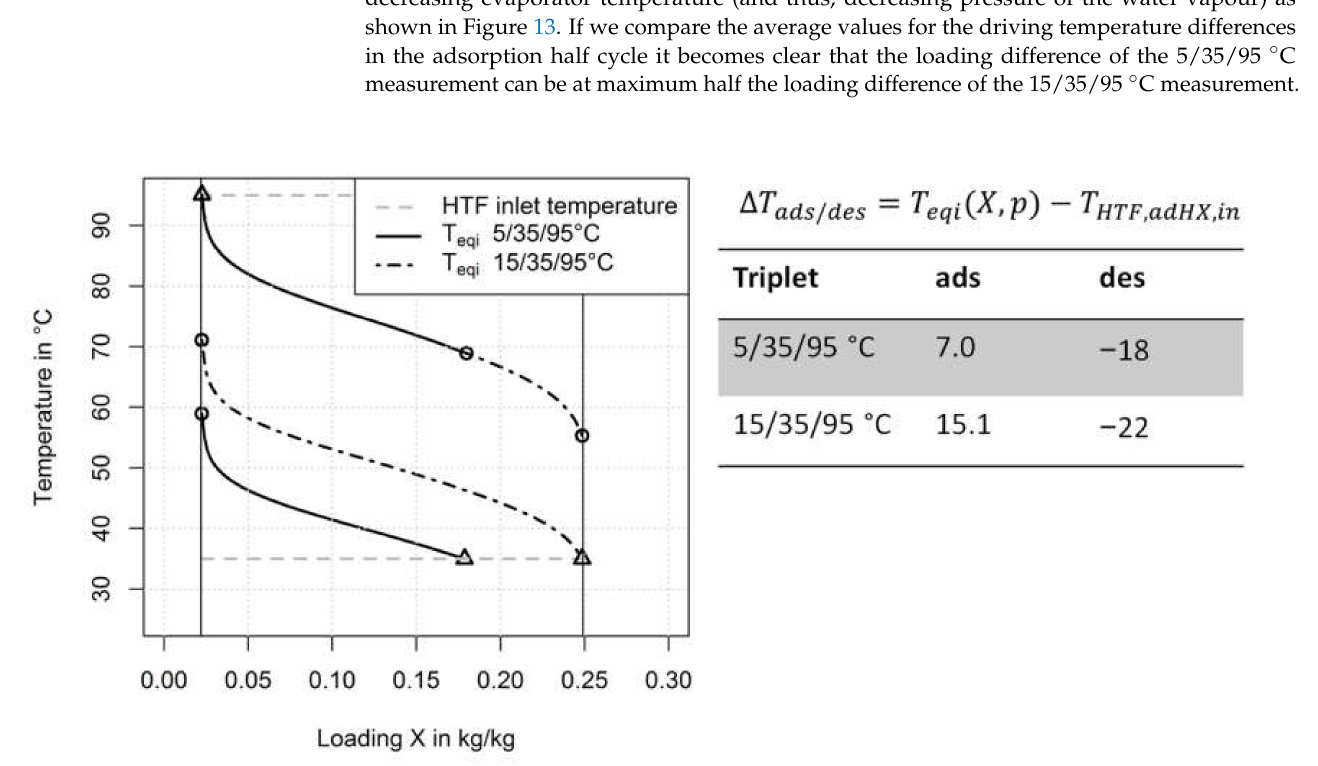
Figure 13. Equilibrium temperature in adsorption and desorption plotted versus loading for two different temperature conditions. The starting points are marked with a circle ‘o’ and the ending points with a triangle ‘ ∆ ’. The difference between the equilibrium temperature and the HTF temperature (here: inlet temperature) is the maximum driving temperature difference during adsorption or desorption. The table shows the average values of the driving temperature difference over the whole loading